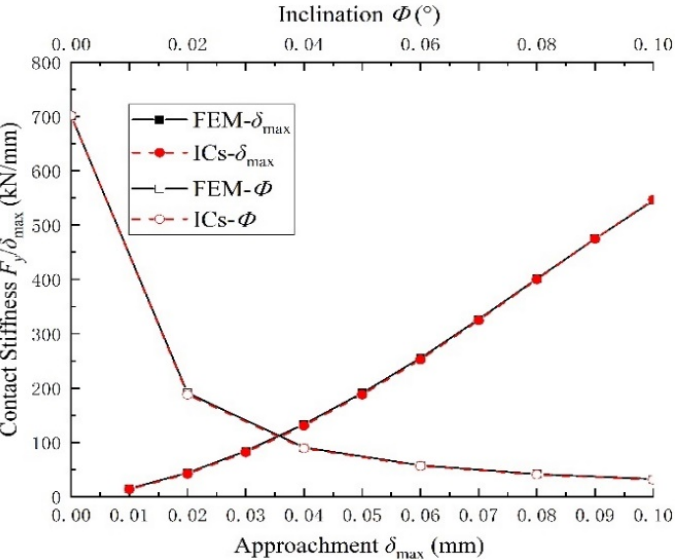
Figure 15. Contact stiffness of the bearing with different approachment and inclination.